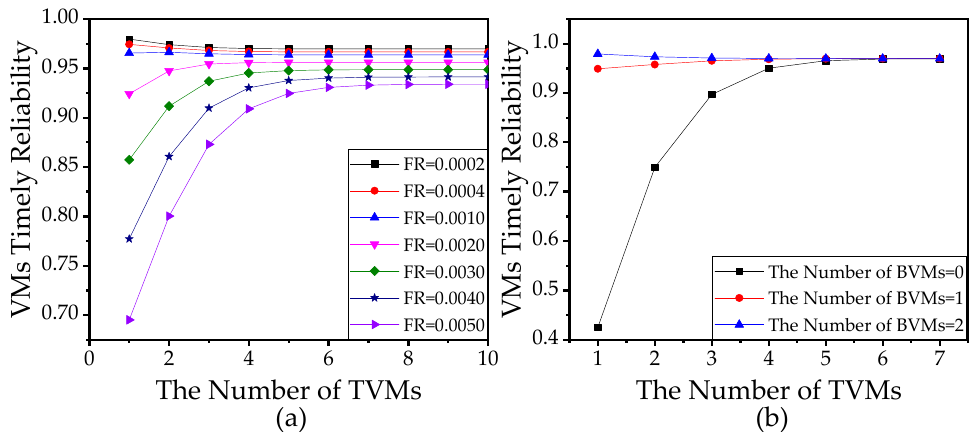
Figure 13. ( a ) VTR versus the number of task VMs (TVMs) with different failure rate (FR). The number of backup VMs (BVM) 𝑑 = 2 . ( b ) VTR versus the number of TVMs with different num- bers of BVMs where the failure rate 𝜃 = 0.0002 . In ( a ) and ( b ), the number of sensors is 10 and the total number of VMs is not fixed. The other parameters used in ( a ) and ( b ) refer to Table 3.